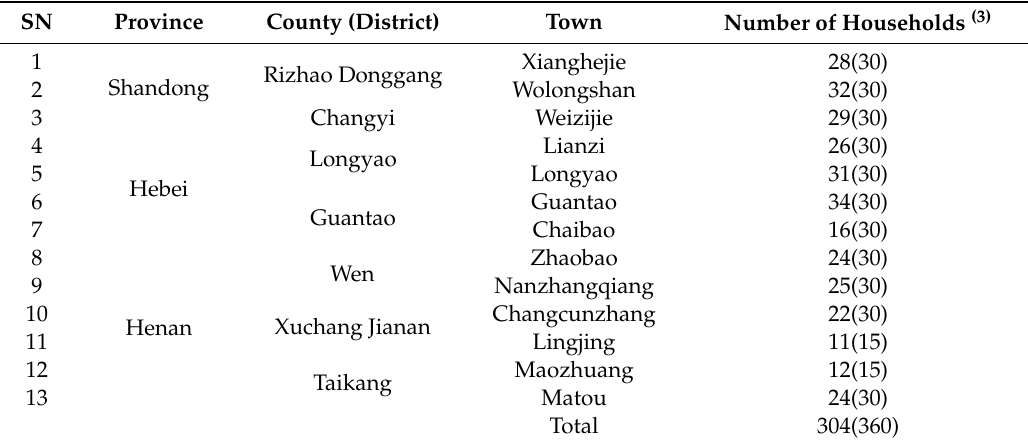
Table 2. Survey data by town in three provinces (the non-reform pilot